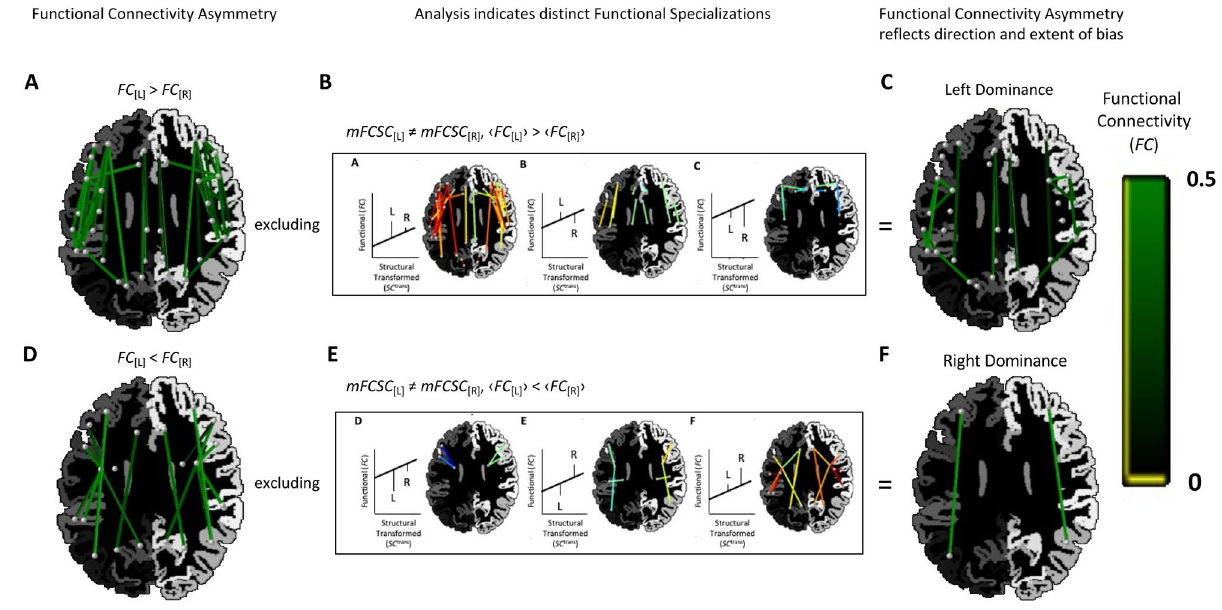
Figure 4. Using MFCSC to detect bilateral pairs where FC asymmetry is indicative of the direction and extent of functional hemispheric dominance. ( A ) Pairs that had leftward FC asymmetry, i.e. FC [L] > FC [R] ( p < 0.00006; Bonferroni corrected with alpha set to 0.05), with colour intensity indicating FC strength, and other conventions as in Fig. 3. ( B ) Excluding connections with mFCSC [L] ≠ mFCSC [R] (connections to exclude correspond to the top row of Fig. 3, which is reproduced within the rectangle). ( C ) The subset of the pairs in panel A where left and right unilateral connections probably share the same brain function (as mFCSC is not different between hemispheres). In these pairs, FC asymmetry is a good indicator for the direction and magnitude of functional hemispheric dominance. ( D–F ) Same conventions as ( A–C ), but for the analysis of pairs that had rightward FC